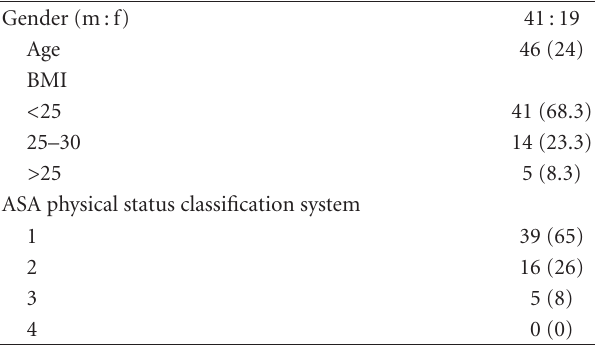
Table 1: Demographic data. Data are shown as absolute number of patients or mean ( ± SD). BMI: body mass index.